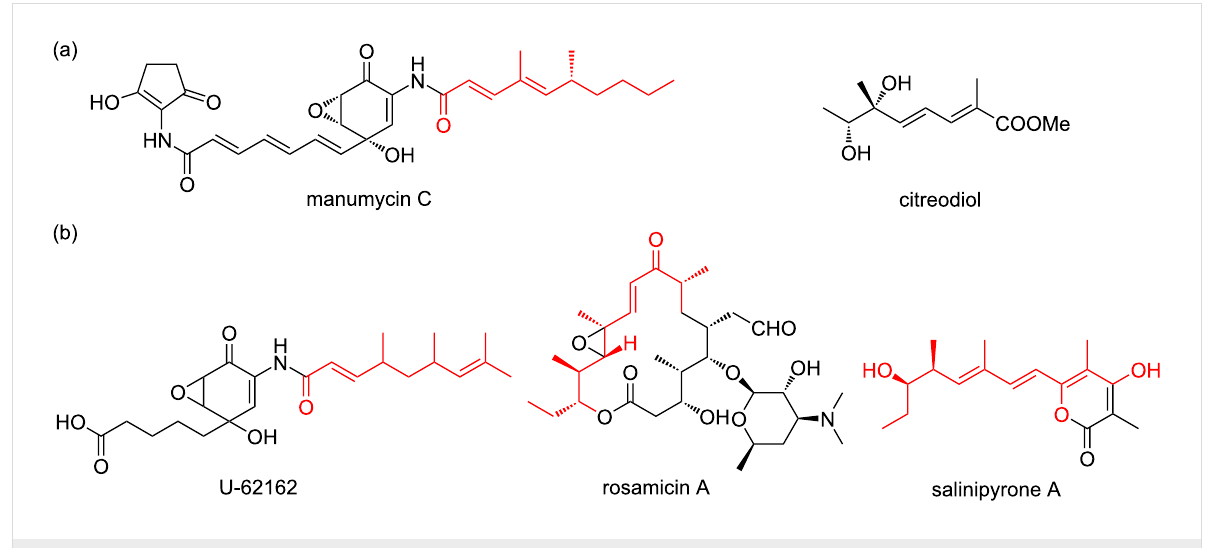
Figure 7: Selected examples of the related compounds derived from the strains in the genus Streptomyces (a) and the family Micromonosporaceae (b).